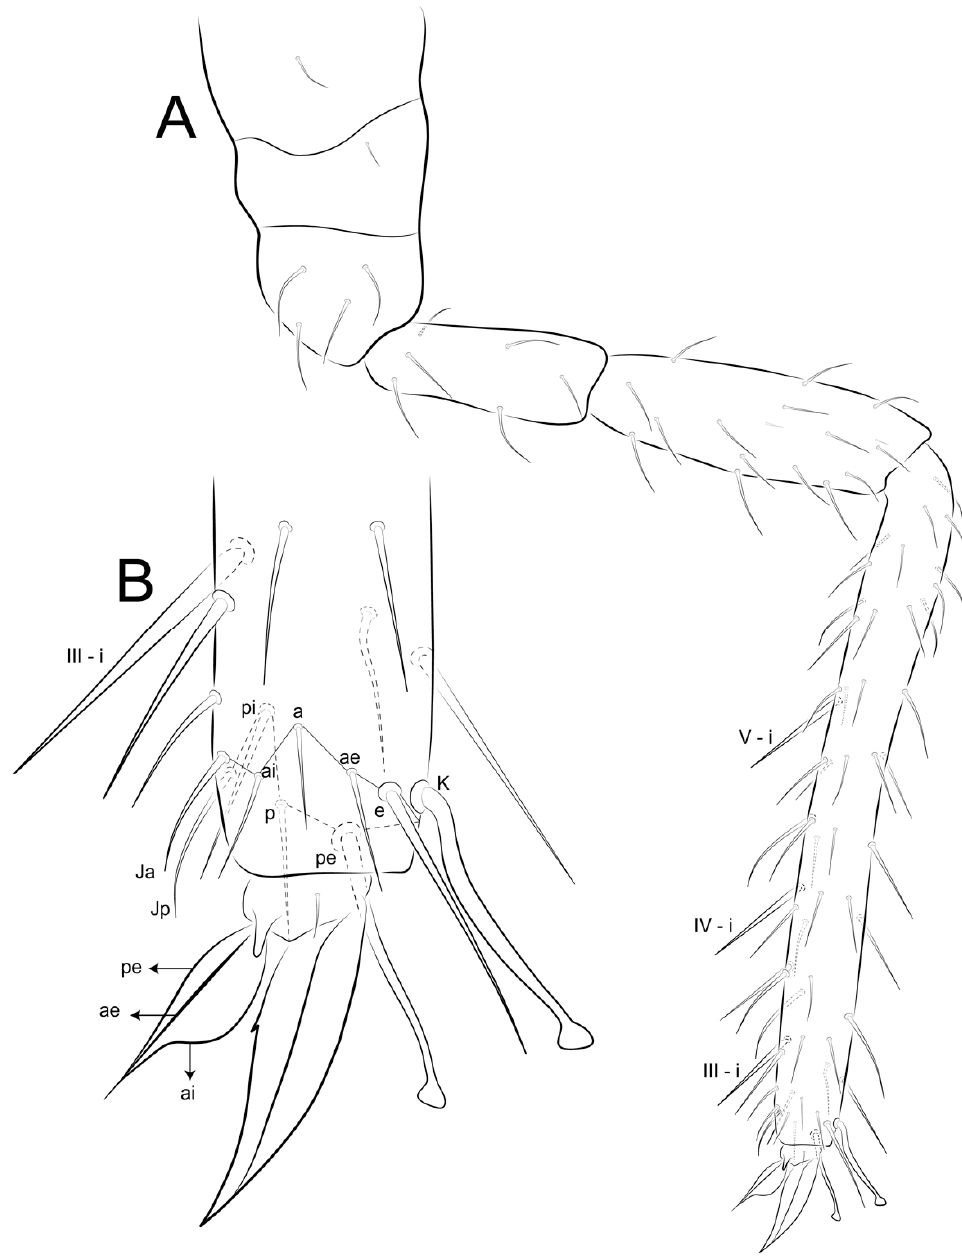
Figure 16. Arlesminthurus caatinguensis sp. nov. male’s leg III (anterior view): ( A ) complete chaetotaxy; ( B ) distal tibiotarsus and empodial complex.